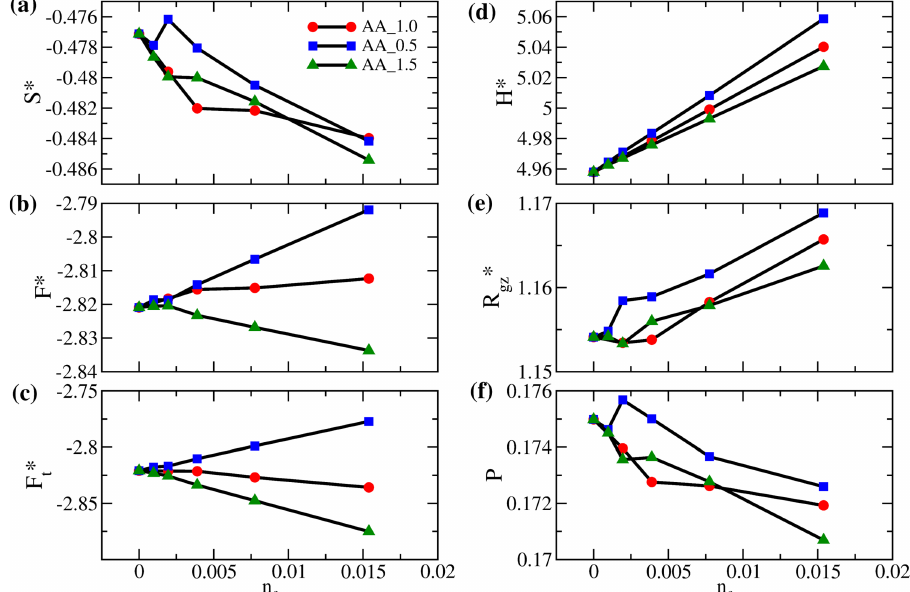
Figure 9. ( a ) Scaled entropy per bead ( S ∗ ), ( b ) scaled free energy per bead for polymer brushes ( F ∗ ), ( c ) scaled total free energy per bead ( F ∗ t ), ( d ) scaled gap thickness ( H ∗ ), ( e ) degree of interpenetration of polymers ( P ), and ( f ) ratio of the z -component actual gyration radius to the reference gyration radius ( R ∗ gz ) as a function of the number fraction of free particles ( n f ) for brushes AA at ε f f = 1 (red circles), 0.5 (blue squares), and 1.5 (green